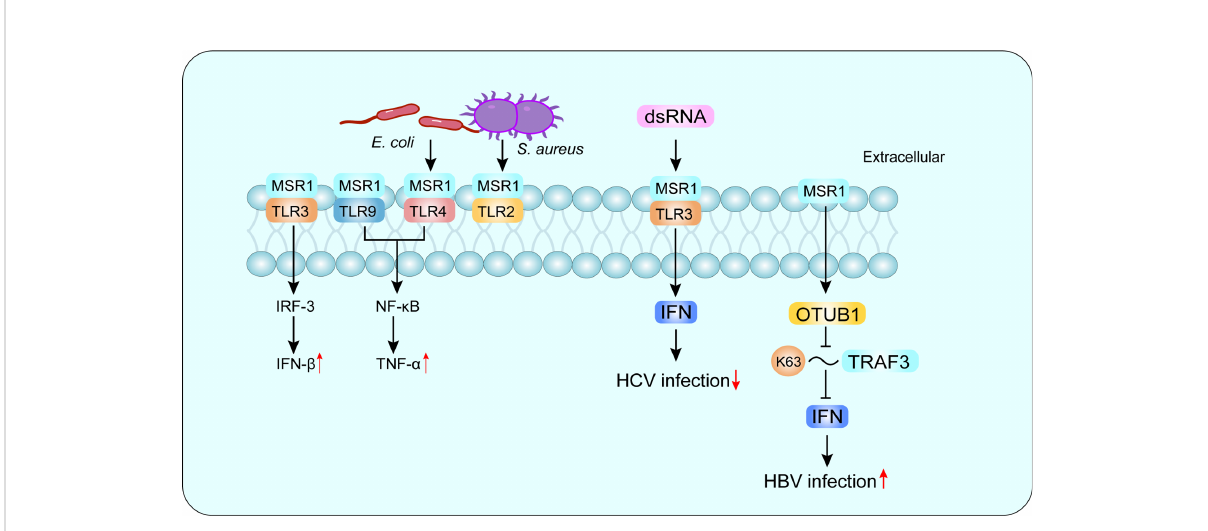
FIGURE 1 MSR1 in recognizing PAMP. MSR1 recognizes a large number of PAMP and plays an important role in host defense. MSR1 can also form co- receptor complexes with other receptors and mediate different or even opposite signaling pathways. For example, MSR1 and TLR4 complex activates phagocytosis of the Gram-negative bacterium Escherichia coli , while MSR1 interacts with TLR2 to promote phagocytosis of the Gram- negative bacterium Staphylococcus aureus . More interestingly, MSR1 promotes HBV infection and suppresses HCV infection. PAMP, pathogen- associated molecular patterns; TLR, Toll-like receptor; HBV, hepatitis B virus; HCV, hepatitis C